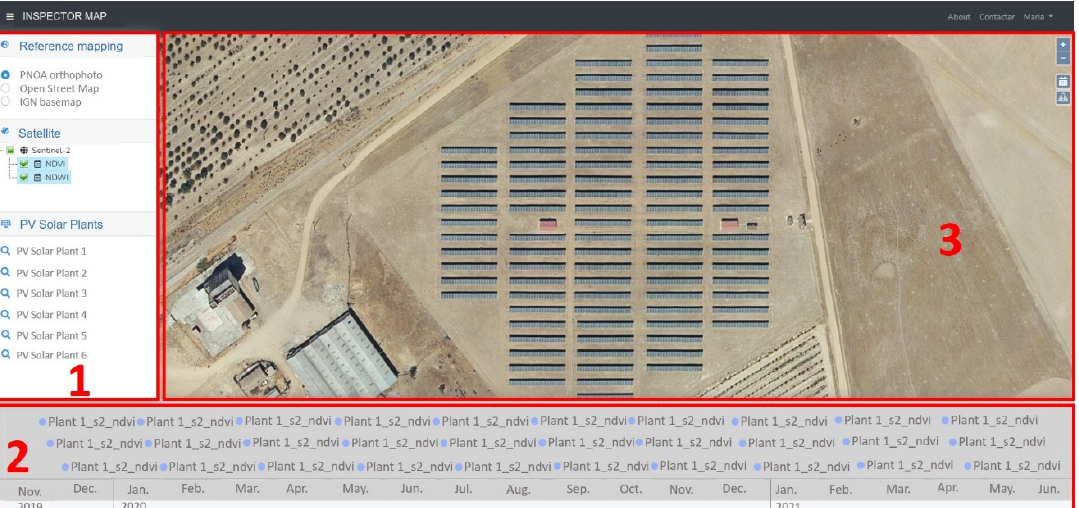
Figure 2. Graphic interface of the SDI INSPECTORMAP developed for the monitoring of photovoltaic plants.